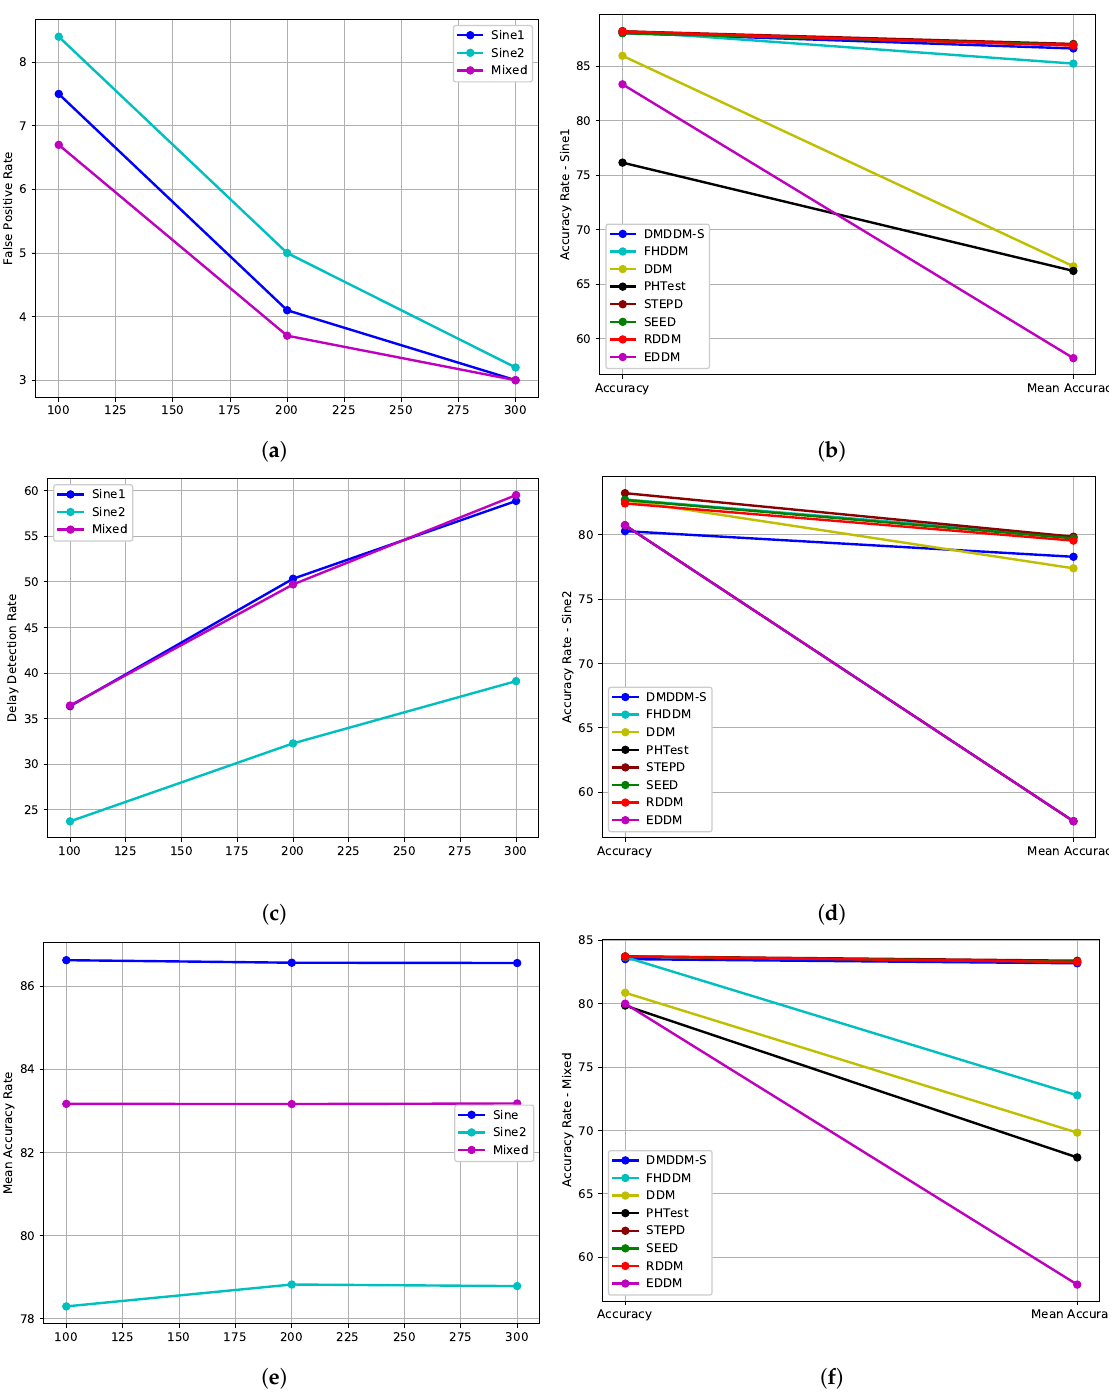
Figure 5. Changing DMDDM-S threshold ( a , c , e ) and the stability of each detector’s accuracy ( b , d , f